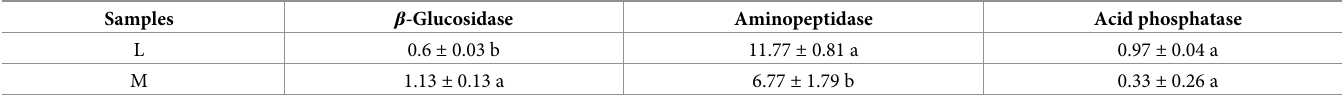
Table 4. Soil enzyme activities related to C, N, and P cycles between moss (M) and non-moss-growth (L) areas in litchi orchard (nmol � g − 1 � min − 1 (30˚C)).